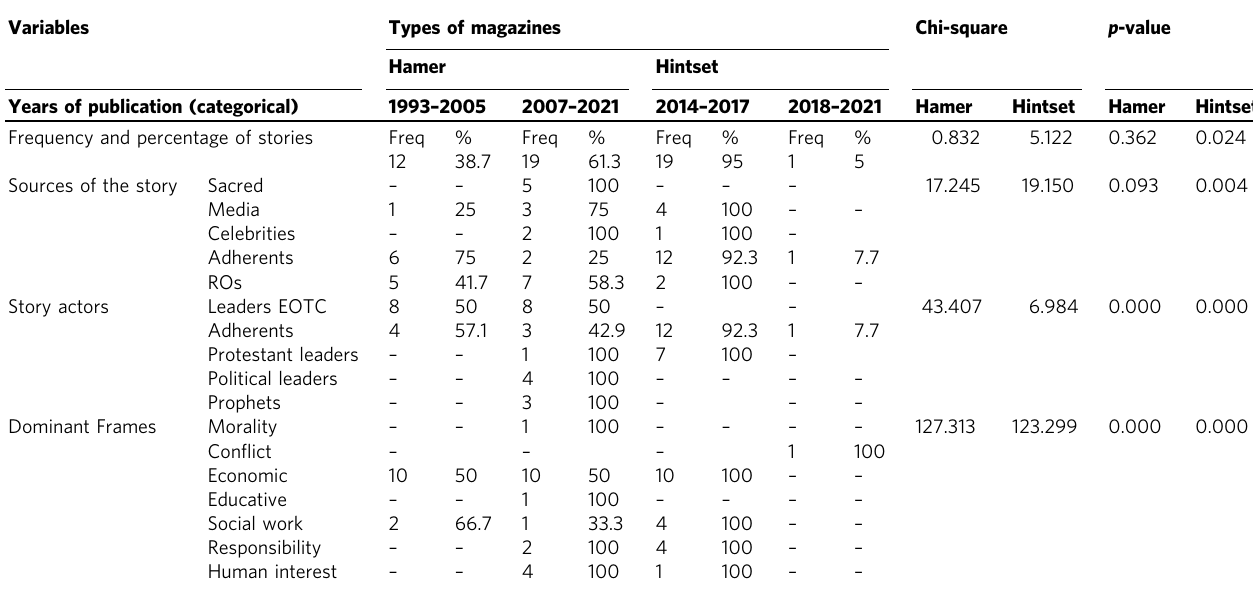
Table 1 Cross-tabulation: Economic development * Types of publication * Years of publication * Sources * Story actors * Dominant